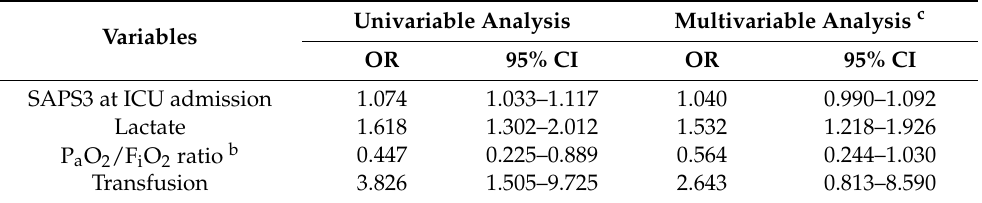
Table 4. Risk factors for HFNC failure in patients with non-pneumonia sepsis ( n = 89) a . Univariable Variables